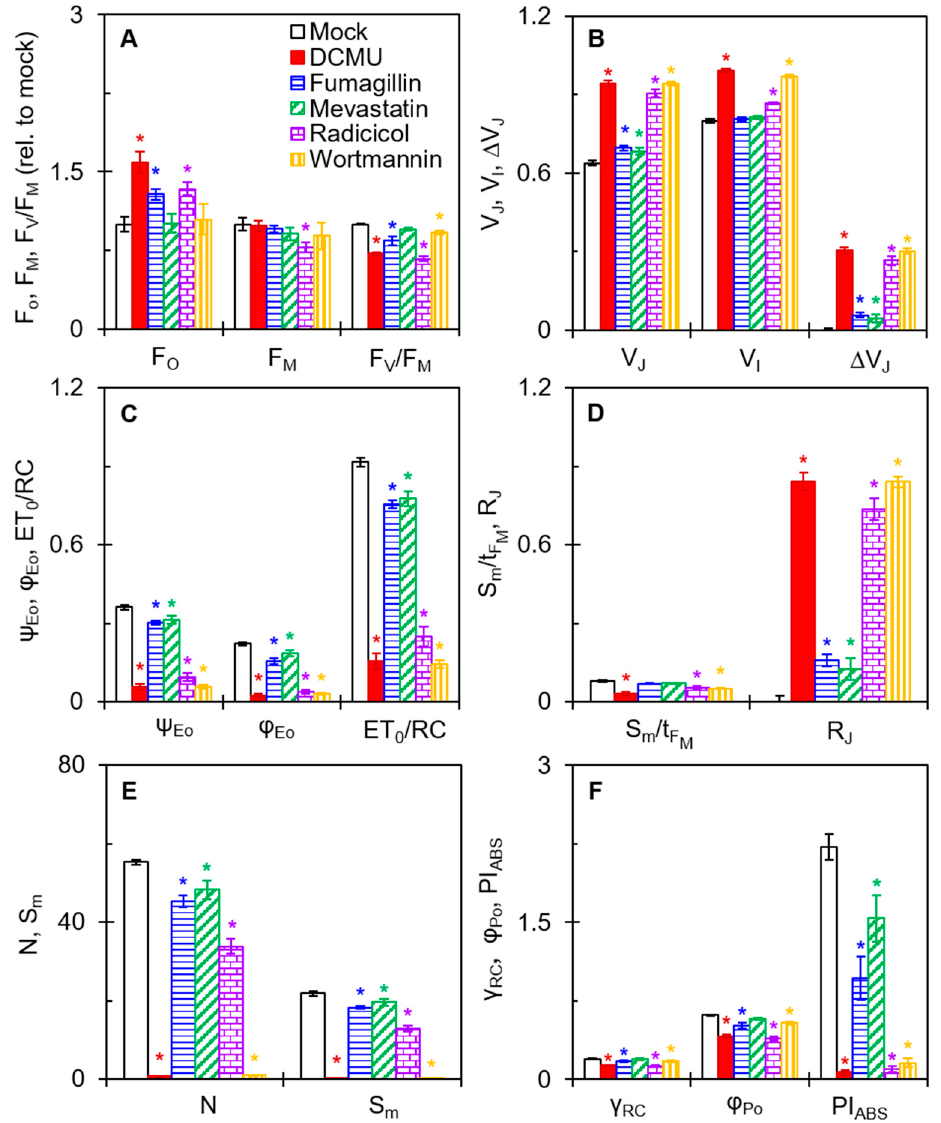
Figure 5. Effects of four mycotoxins on the selected JIP test parameters of C. reinhardtii cells. ( A ) The relative values of F O , F M , and F V /F M after mycotoxins treatment compared with mock. ( B ) The values of V J , V I , and ∆ V J . ( C ) The values of ψ Eo , ϕ Eo , and ET 0 /RC. ( D ) The values of S m /t FM and R J . ( E ) The values of N and S m . ( F ) The values of γ RC , ϕ Po , and PI ABS . Each parameter is the average of 30 measurements. * indicates significance at p < 0.05.